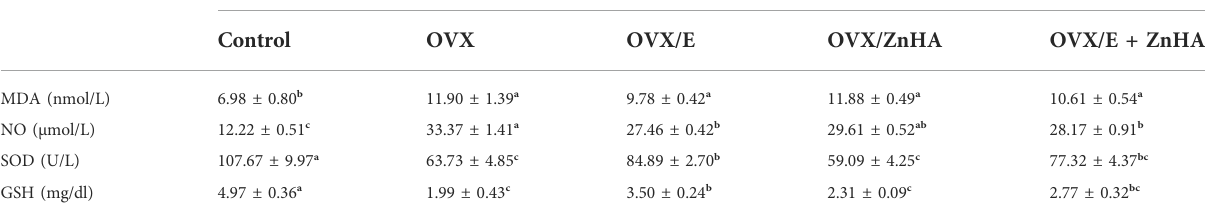
TABLE 3Effects of estrogen (E2) andzinchydroxyapatite nanoparticles (ZnHA) treatmentsonserum oxidative/antioxidant biomarkersofcontroland treated rats.